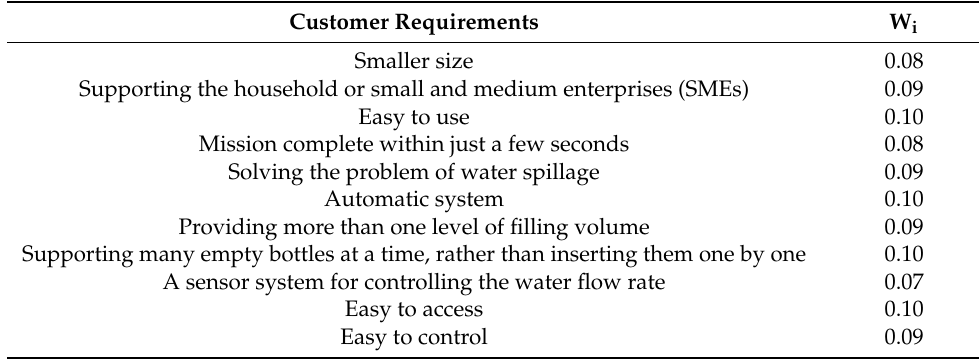
Table 4. The importance weight of the customer